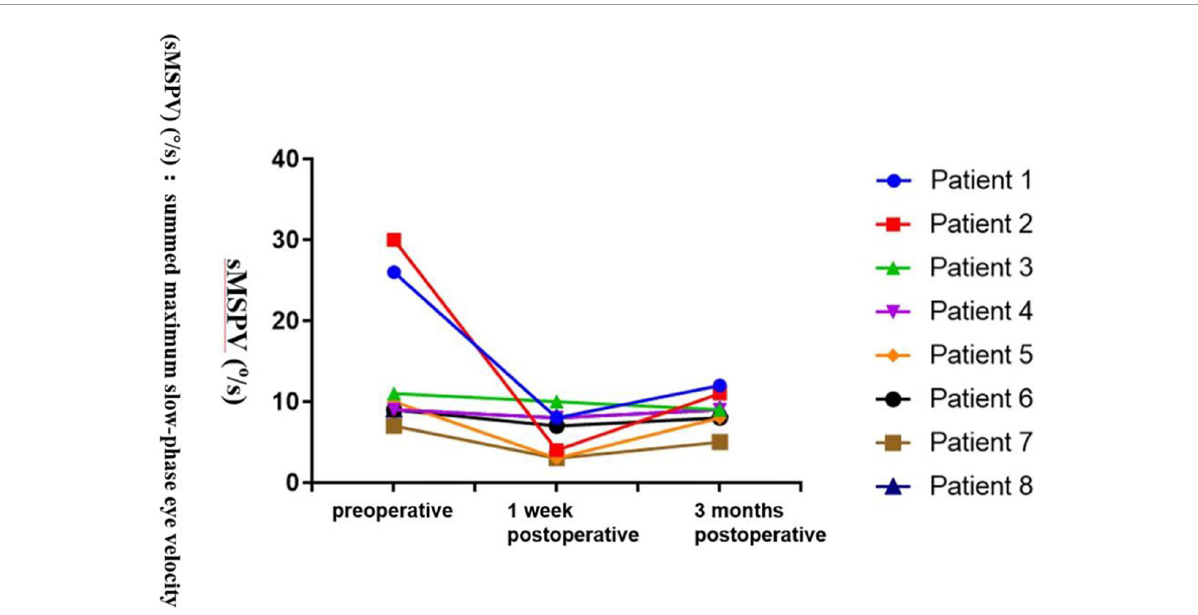
FIGURE4 Caloric test results [summed maximum slow phase velocity of the eye, caloric sMSPV ( ◦ /s)] of the operated side of 8 patients with vertigo in group 2 before and after surgical plugging of external semicircular canal. Each patient is color coded. Vestibular function examinations performed at 1 week and 3 months postoperatively revealed that the affected side was weakened in all eight patients. The vestibular function of the patient was the worst one week after the operation, and gradually recovered in the later period, but it was not normal.